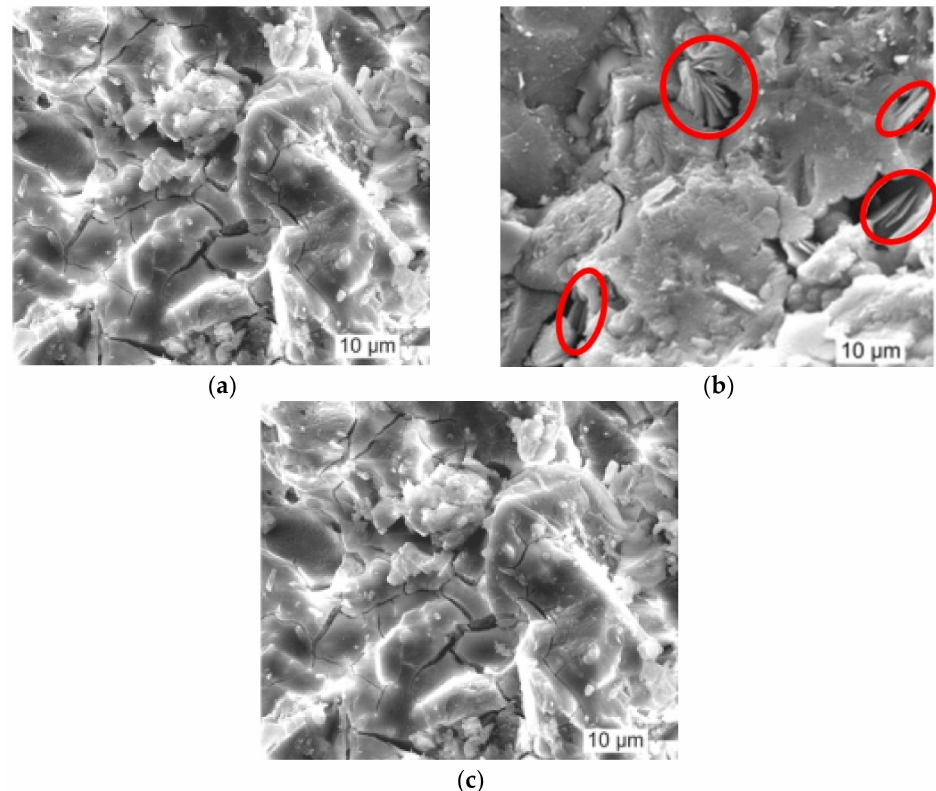
Figure 4. SEM images of the hydration products in the absence of sulfates giving: ( a ) gel-like hydration products covering the tricalcium aluminate surface (~5 min), ( b ) plate-like intermediated hydrates (~1 h), and ( c ) hexagonal platelet-like hydration products (8–24 h)